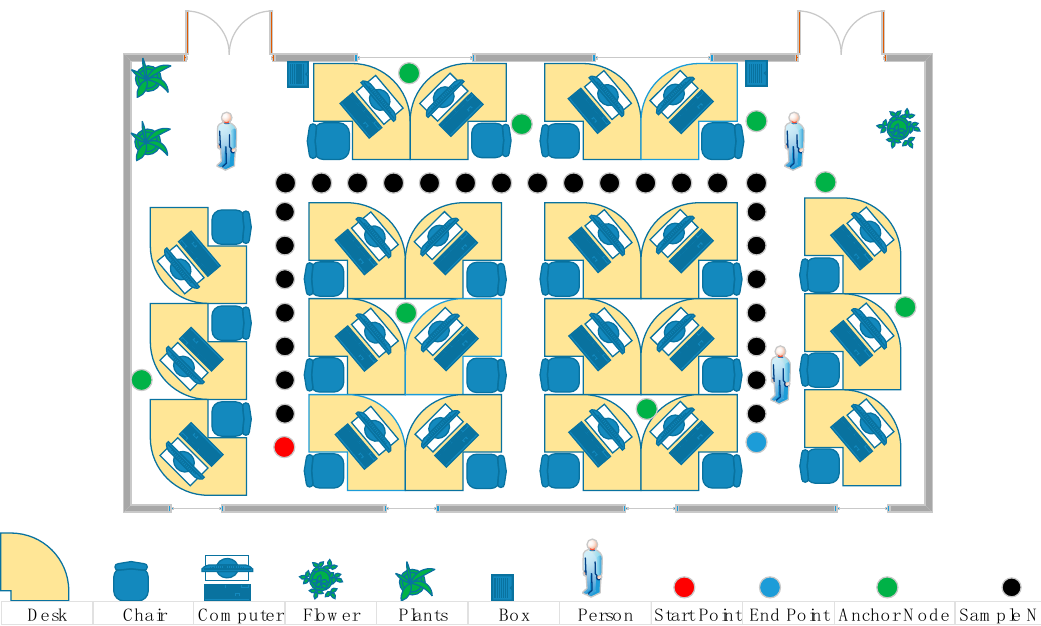
Figure 11. Deployment of experiment.